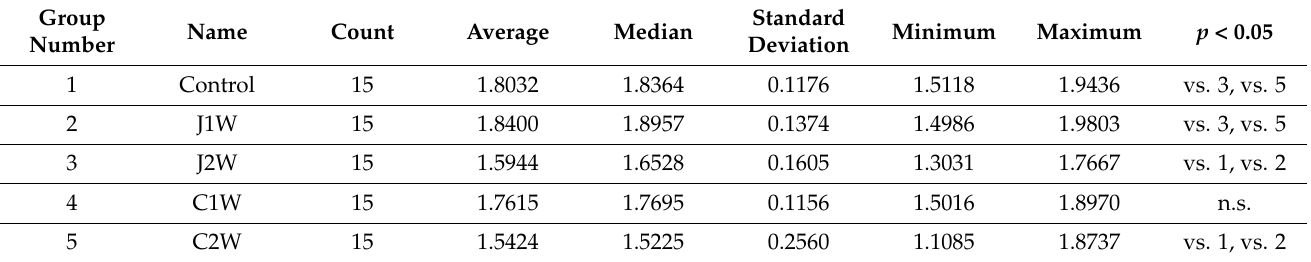
Table 1. Summary statistic of fractal dimension value, and results of Kruskal–Wallis multiple compar-